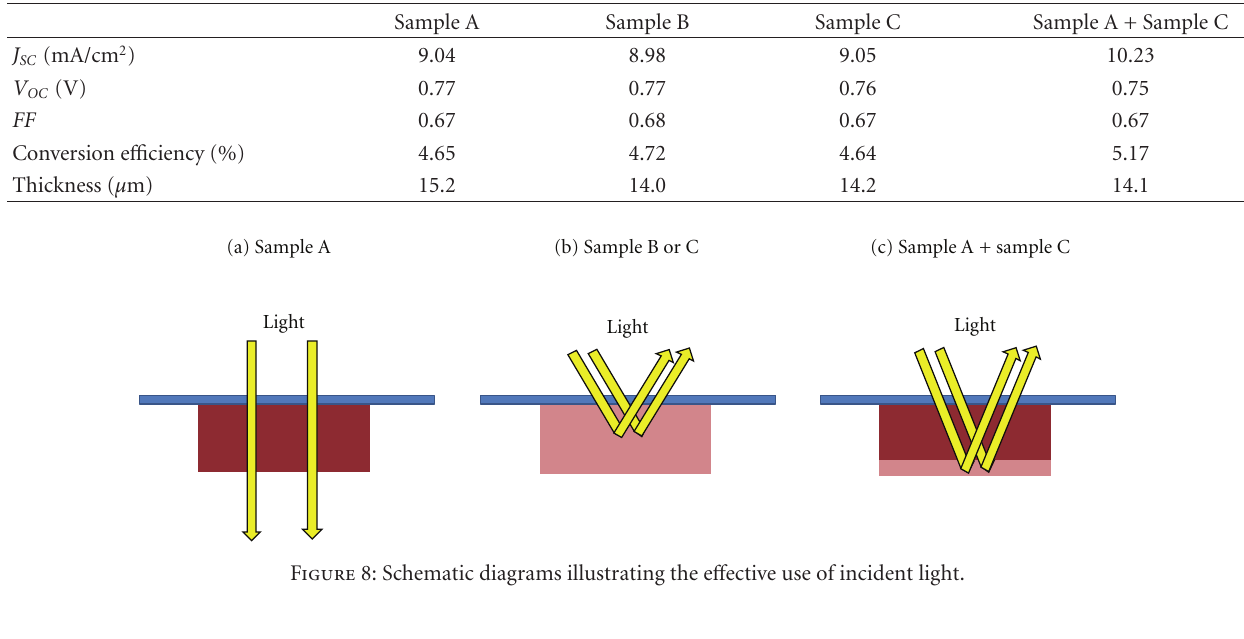
Table 1: PV properties of DSSCs prepared from TiO 2 dispersions.